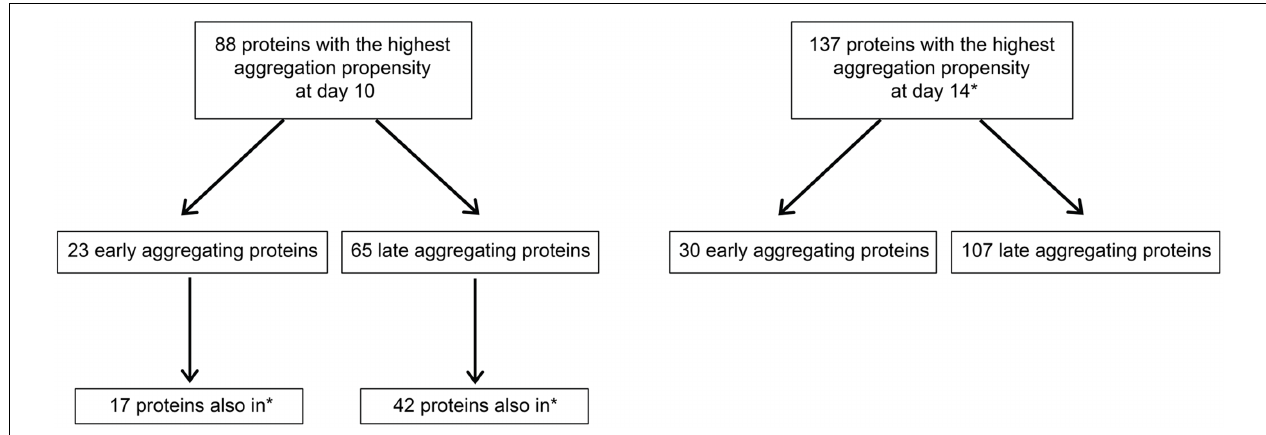
FIGURE 2 | Schematic summarizing numbers of early- and late-aggregating C. elegans proteins detected by quantitative mass spectrometry (also see Supplementary Tables 3, 4). Proteins with the highest aggregation propensity at day 10 or day 14 are defined as proteins quantified in the top 25th percentile compared to day 6. Proteins with the highest aggregation propensity at day 6 are defined as proteins quantified in the top 25th percentile compared to day 2. Quantification was performed with two biological replicates and all numbers represent only proteins in the top 25th percentiles from both replicates. ∗ Proteins also among the 137 proteins with the highest aggregation propensity at day 14 (in top right